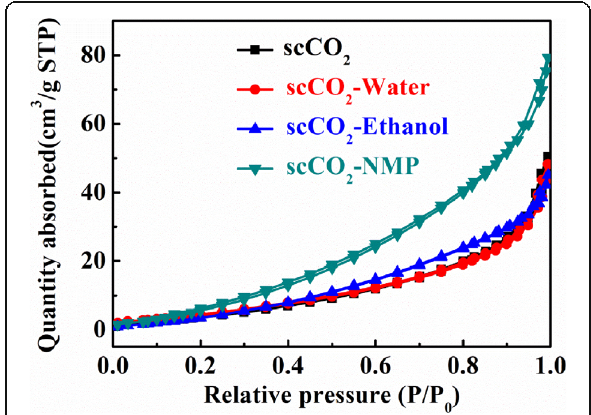
Fig. 5 BET analysis on MoS 2 exfoliated from various solvents